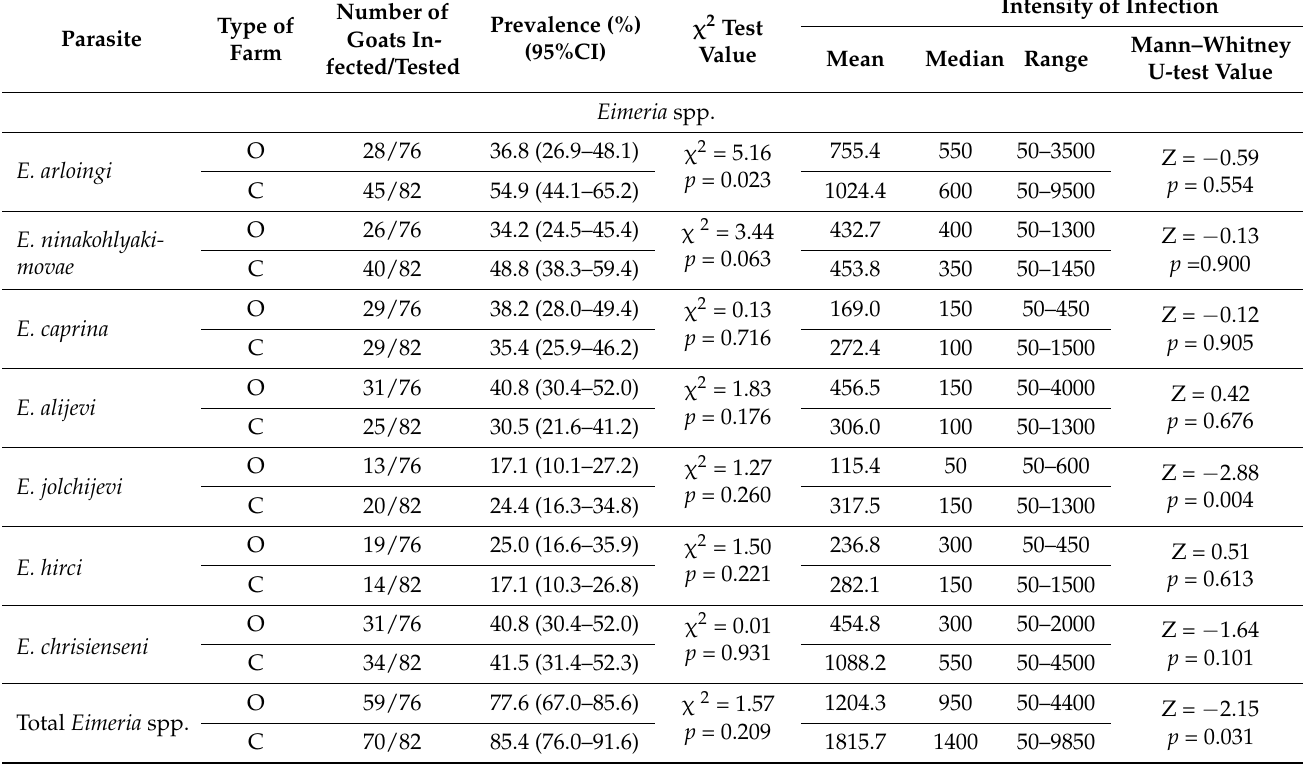
Table 3. Prevalence and intensity of infection with Eimeria spp. among the tested